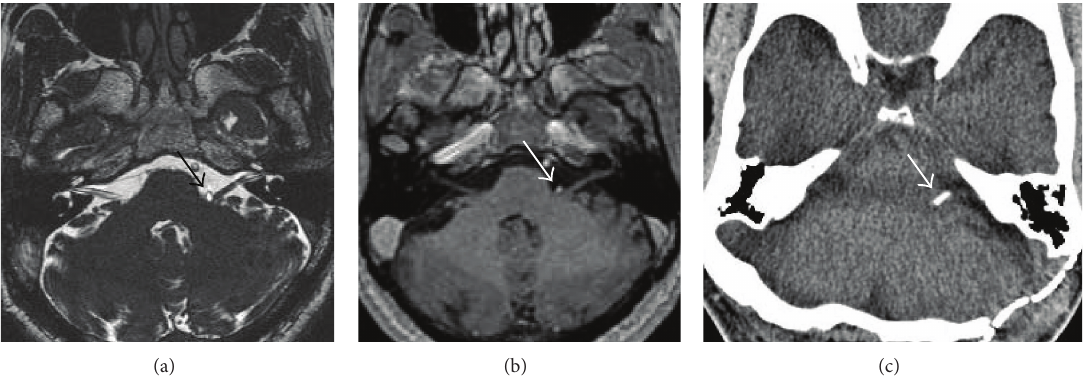
Figure 15: Neurovascular compression in a patient presenting with left hemifacial spasm. Axial CISS (a) and T1 postcontrast MRI (b) images demonstrate the left vertebral artery (arrow) abutting the left facial nerve at the root entry zone. Axial noncontrast CT scan (c) demonstrates the hyperdense postsurgical material from microvascular decompression